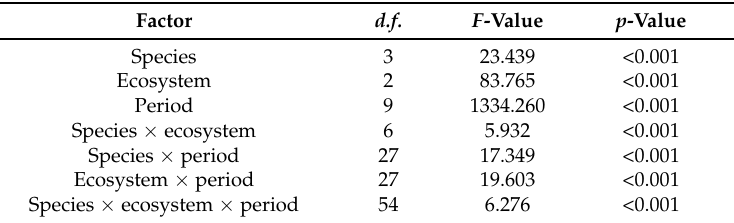
Table 3. The effects of litter species, ecosystem type, decomposition period, and their interaction on cellulose degradation rate (%/month) during foliar litter decomposition which were tested by a repeated-measure general linear model.